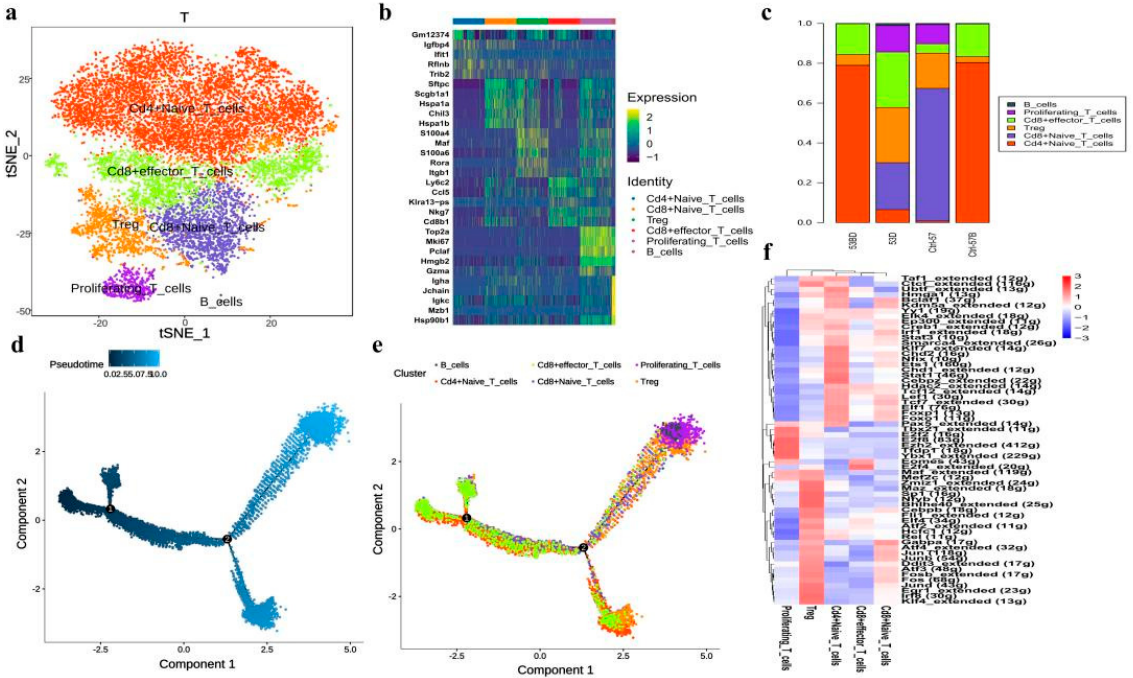
Figure 5. Single-cell transcriptional profiling of T cells and trajectory branch. ( a ) The T-SNE presentation of the T cell clusters and B cells. ( b ) The heatmaps of hierarchically clustered top 10 differentially expressed genes (DEGs) across five groups of T cells and one group of B cells. The gene names were listed to the right. ( c ) The bar plot shows the percentages of T cell clusters and B cells in each studied subject. ( d ) Simulation of the differentiation trajectory of T cells subtypes. ( e ) Cell source transition. ( f ) The heatmap exhibits the average regulon activities of transcription factors in different T cellular types, the color key from blue to red indicates relative expression levels from low to high.